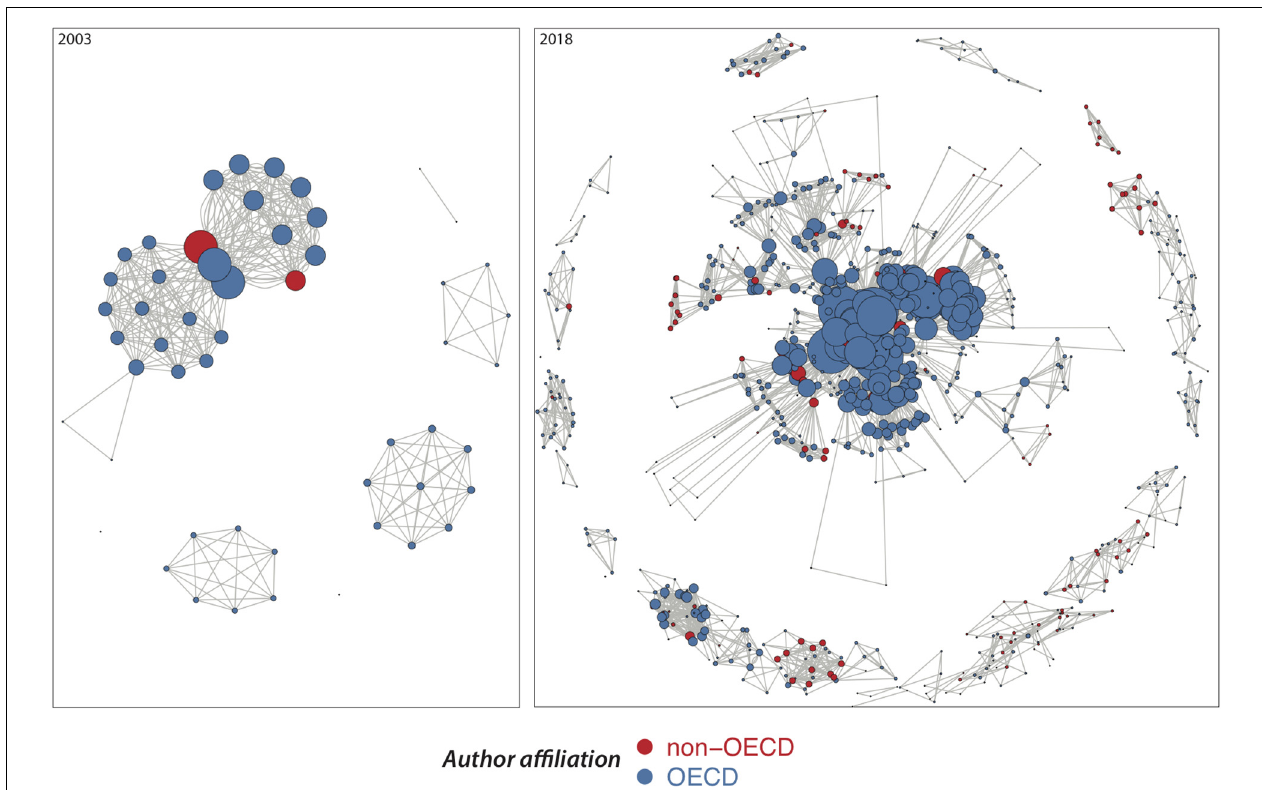
FIGURE 4 | Networks of co-authors compared between articles published in 2003 and 2018 disaggregated by affiliation of authors (OECD vs. non-OECD). Each node represents a unique author/affiliation combination while each edge represents collaboration between authors on a publication; the size of the node indicates the number of articles that author contributed to that year. The length of the edge indicates how close authors are to each other (the more co-authored publications, the closer the authors). Each plot displays the co-authorship networks of all papers published in that year—and thus the clusters in each year are independent from each other—and illustrate annual shifts in collaborative networks. See Supplementary Figure 4 for